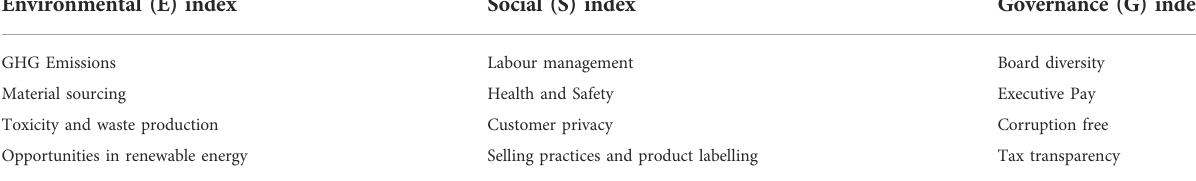
TABLE 1 List of factors for energy sector to generate better ESG reports. Source: Own elaboration.